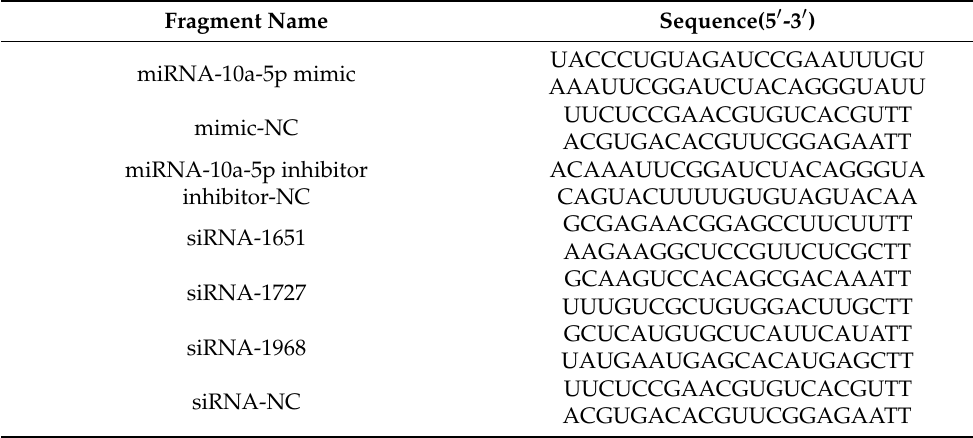
Table 3. Oligonucleotide sequences for overexpression and inhibition.